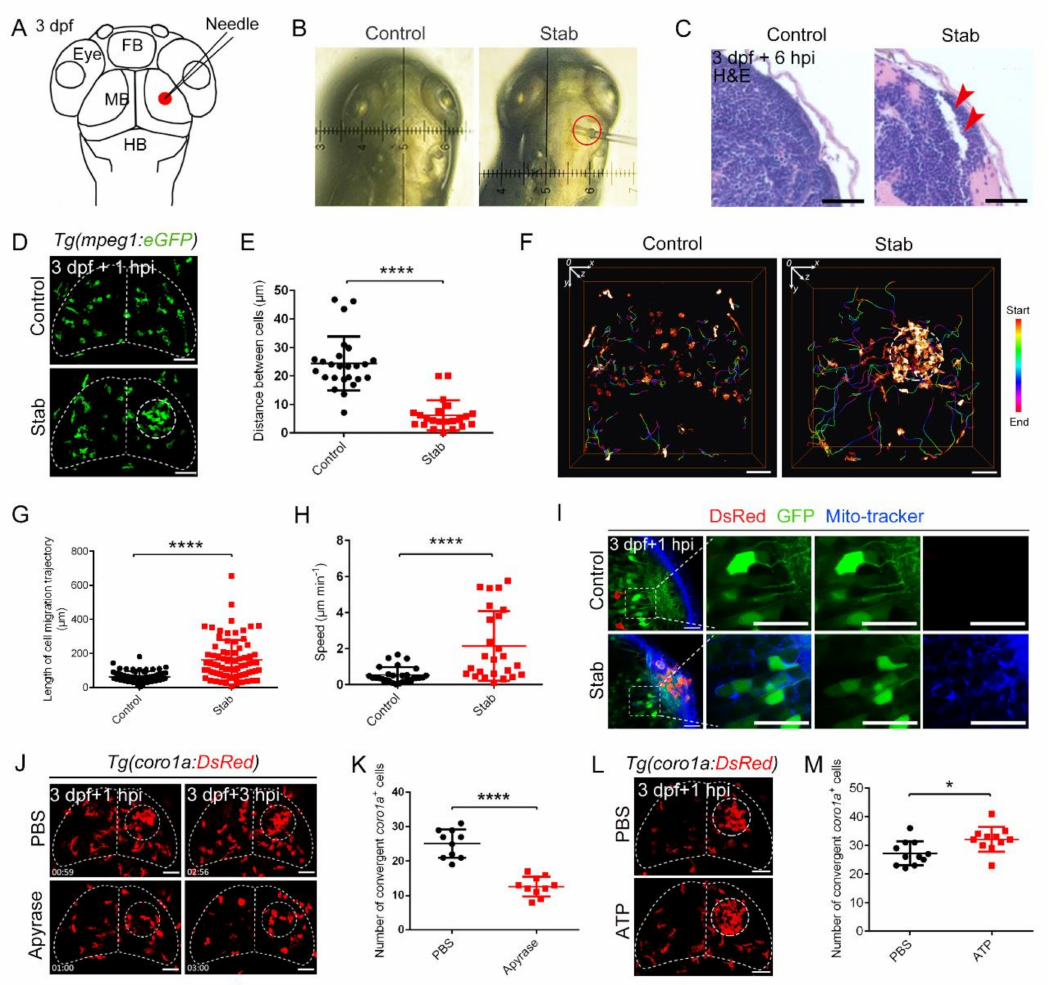
Figure 1. Predominant involvement of macrophages in response to traumatic brain injury caused by stabbing in zebrafish. ( A ) Stab model. The red dot marks the lesion core (LC). FB, forebrain; MB, midbrain; HB, hindbrain. ( B ) An actual operation diagram of the stab. The horizontal width of damage was about 130 µ m. ( C ) A paraffin section was stained with hematoxylin and eosin (H&E) staining. The red arrowheads indicate the brain tissue loss. Scale bar, 20 µ m. ( D ) The accumulation of macrophages in Tg(mpeg1:GFP) at 1 hpi. The white dotted line shows the major area of macrophage aggregation. Scale bar, 50 µ m. ( E ) Statistical analysis of the distance between coro1a + cells in LC. Control, 24.35 ± 1.89 µ m n = 25; Stab, 6.14 ± 1.12 µ m n = 22. ( F ) Spatial and temporal migration of macrophages. Scale bar, 50 µ m. ( G ) Length statistics for macrophage migration trajectories. Control, 62.14 ± 3.881 µ m, n = 71; Stab, 161.7 ± 13.42 µ m, n = 78. ( H ) Statistical analysis of the movement speed of coro1a -DsRed + cells after injury. Control, 0.5309 ± 0.08210 µ m min − 1 n = 28; Stab, 2.148 ± 0.3875 µ m min − 1 n = 25. ( I ) MitoTracker signals were detected in the damage sites. The right three panels are the enlarged views of the boxed regions in the left panel. Scale bar, 20 µ m. ( J ) Aggregation of macrophages after apyrase injection in Tg(coro1a:DsRed) embryos at 1 hpi and 3 hpi. Scale bar, 50 µ m. ( K ) Statistical number of coro1a + cells after injury at 1 hpi. PBS, 25.10 ± 1.303 n = 10; apyrase, 12.60 ± 0.9092 n = 10. (L) Observation of macrophage aggregation after ATP injection at 1 hpi. Scale bar, 50 µ m. ( M ) Statistical number of aggregated coro1a + cells in ( L ). PBS, 27.18 ± 1.278 n = 11; ATP, 32.09 ± 1.317 n = 11. (Data are shown as mean ± SEM. *, p < 0.05; ****, p <